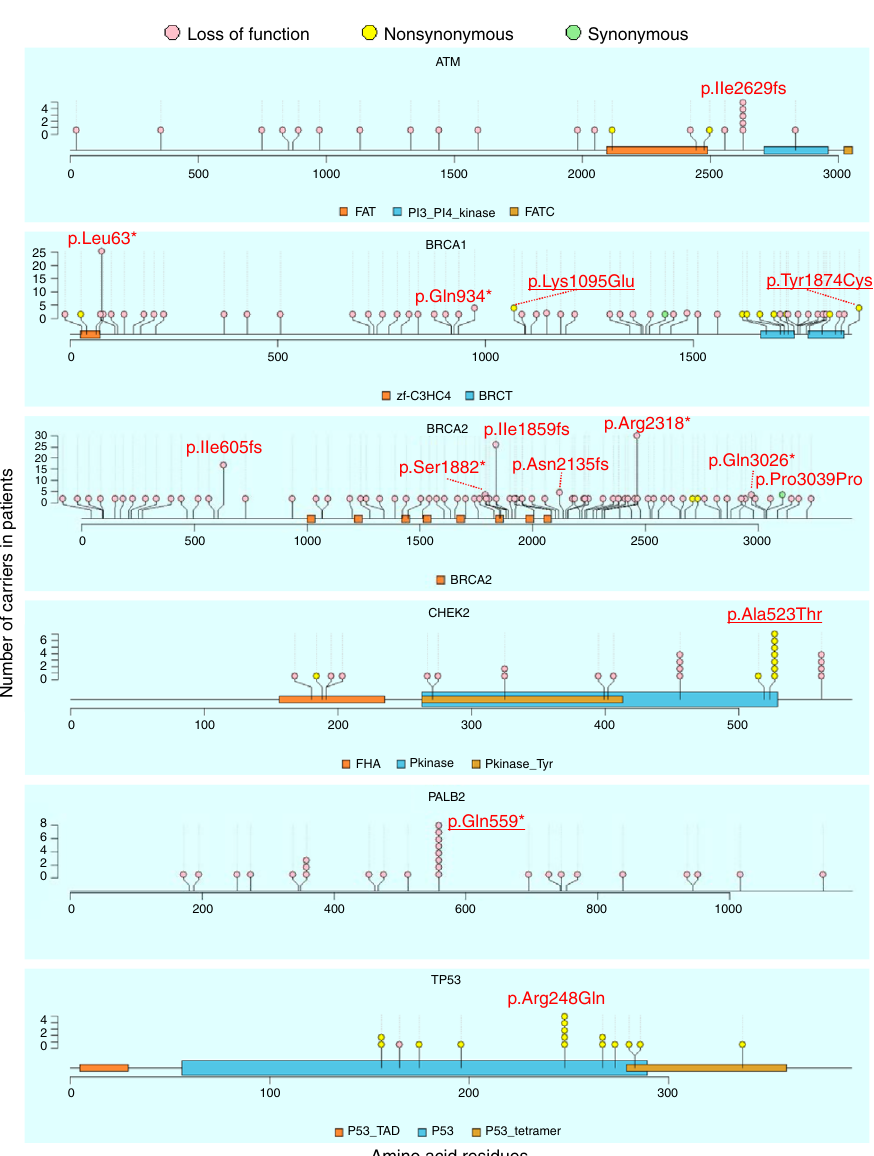
Fig. 1 Location and the number of frequent pathogenic variants in six genes in Japanese breast cancer women. Locations of frequent pathogenic variants found in patients and domains in proteins are shown by lollipop structures, with the variant type indicated by color. Pink, yellow, and green circles indicates loss of function, non-synonymous, and synonymous variants, respectively. The x -axis re fl ects the number of amino acid residues, and the y -axis shows the total number of patients with each pathogenic variant. HGVS.p of frequent variants with fi ve or more patients are shown and four variants newly identi fi ed as pathogenic variants are